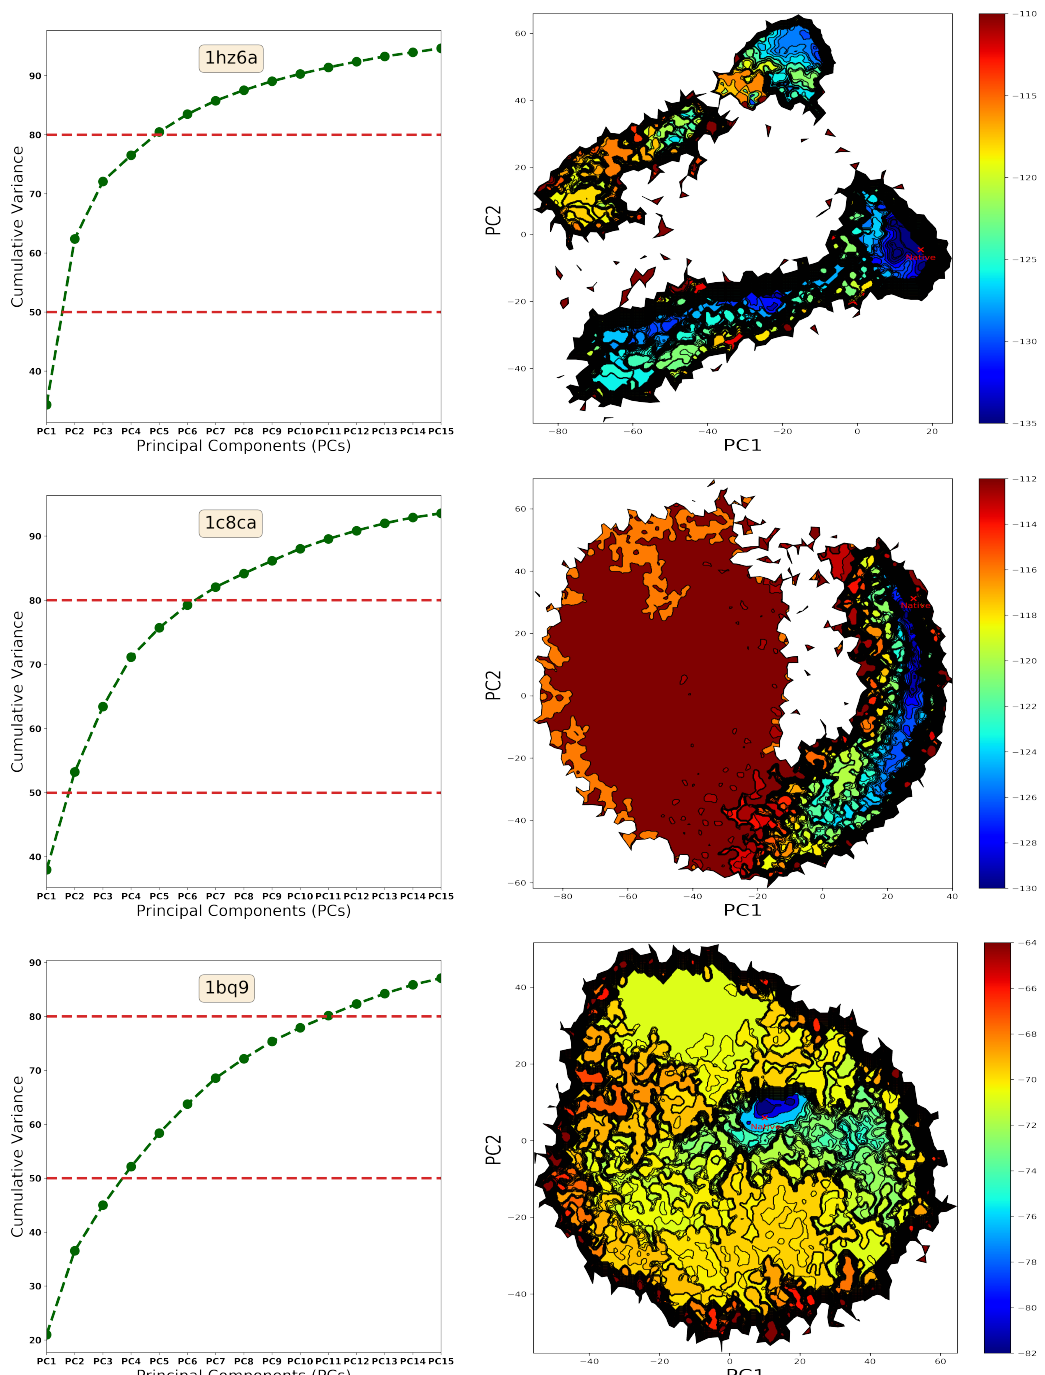
Figure 3. Results are shown the medium targets. The left panel shows the accumulation of variance for the PCs obtained from PCA of generated decoys. The right panel shows the reconstructed landscape over the PC1-PC2 grid. The contour lines show the basin boundaries. The location of a known native structure for each target protein from the easy category highlighted here is marked by a red